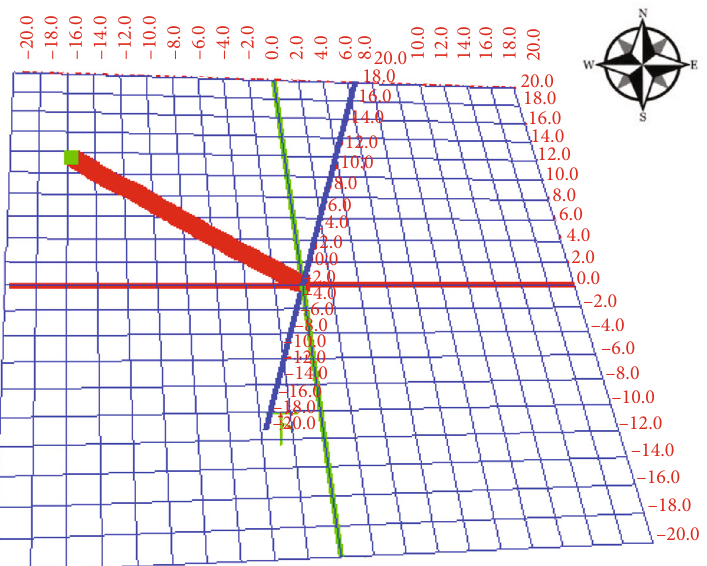
Figure 11: Main control page of borehole track of gas drainage.